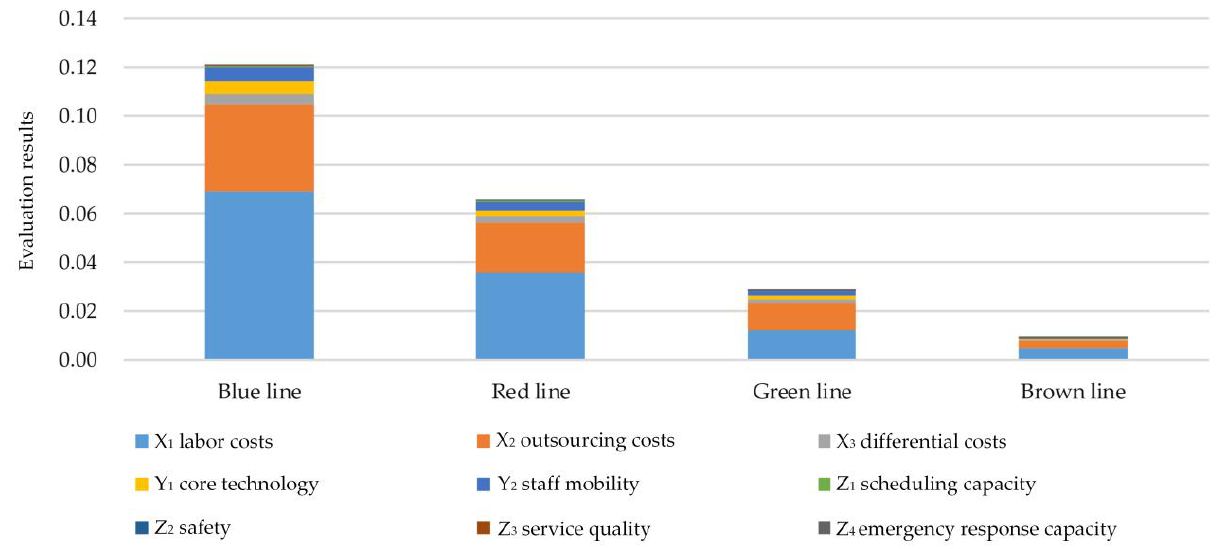
Figure 10. The weights of evaluation factors in the 3rd layer of the blue line, red line, green line, and brown line.